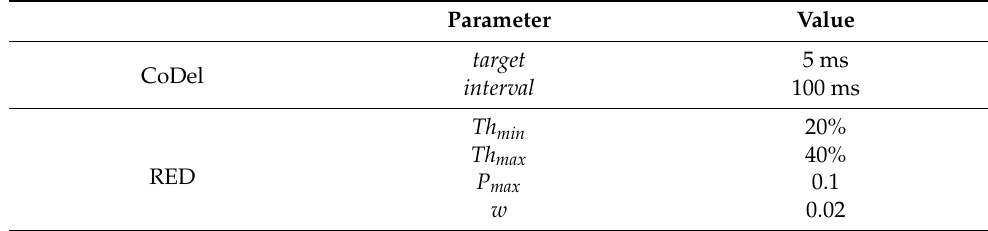
Table 1. Configuration settings of CoDel and